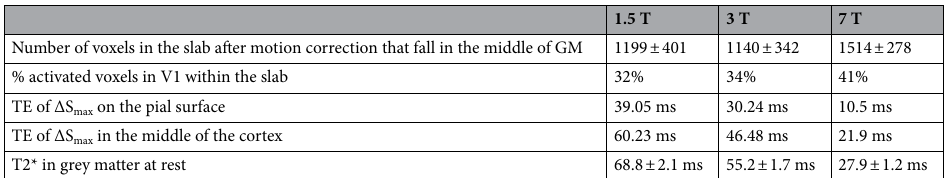
Table 2. Comparison of basic activation related results across field strengths.